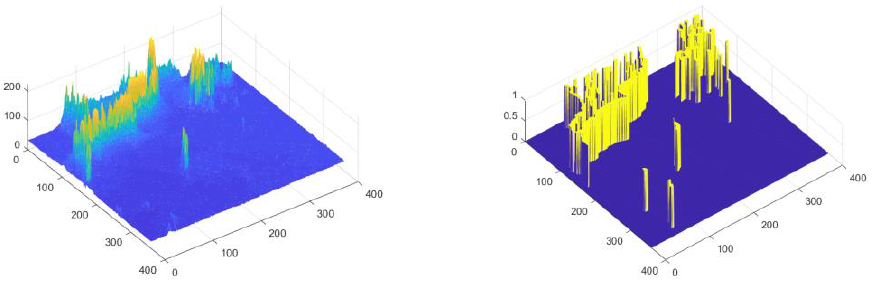
Figure 3. Comparison of remote sensing images before ( left ) and after ( right ) segmentation by adaptive threshold.